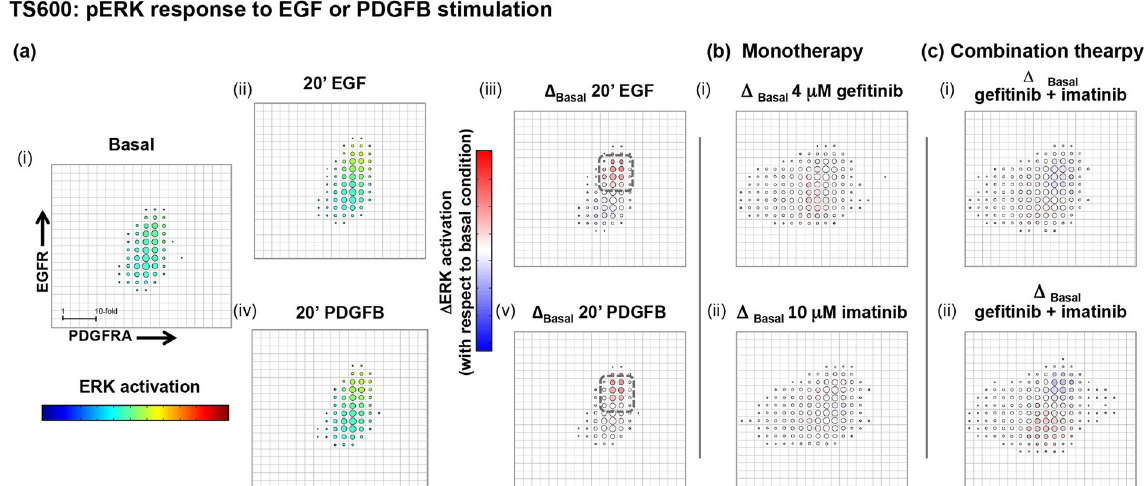
Figure 4. Balance of RTK expression determines tumorsphere p-ERK response to ligand and pathway inhibitors. Phospho-ERK activation was analyzed as a function of EGFR and PDGFRA expression and plotted as in Fig. 3. ( a ) Ligand effect on p-ERK. (i – v) EGF and PDGFB stimulate p-ERK only in cells harboring high levels of both RTKs (cell-bins in dashed squares) and activation patterns are similar for both ligands. ( b ) Mono- and ( c ) combination RTK inhibitor treatment effect on p-ERK: Treatment of TS600 with either (i) gefitinib or (ii) imatinib or ( c ) dual inhibition in the presence of ligand demonstrates a similar pattern of mixed response among cell populations defined by RTK expression, with greater inhibition seen in populations with higher EGFR and PDGFRA